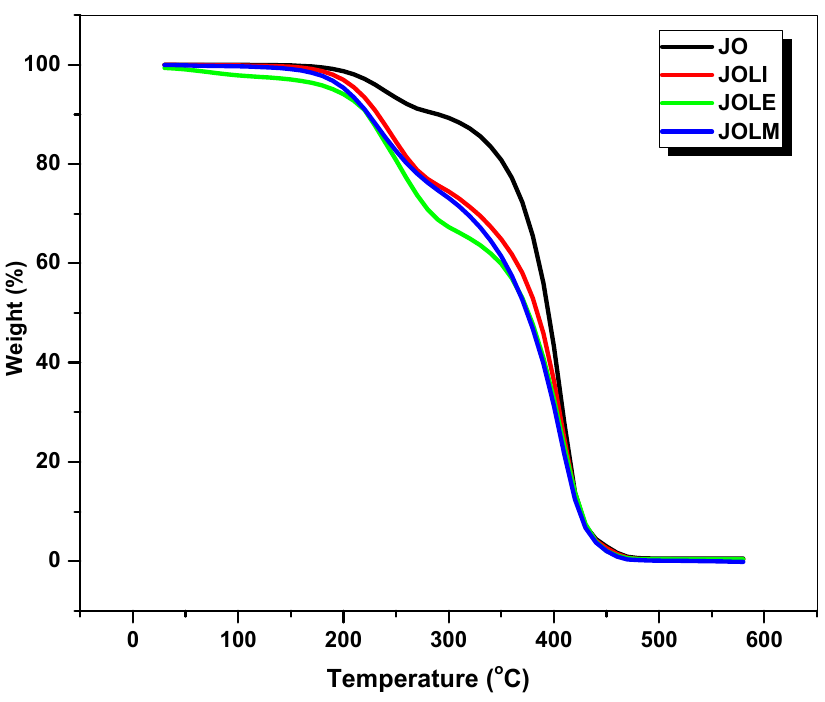
Figure 5. TGA thermograms of the JOL, JOLI, JOLE, and JOLM samples.